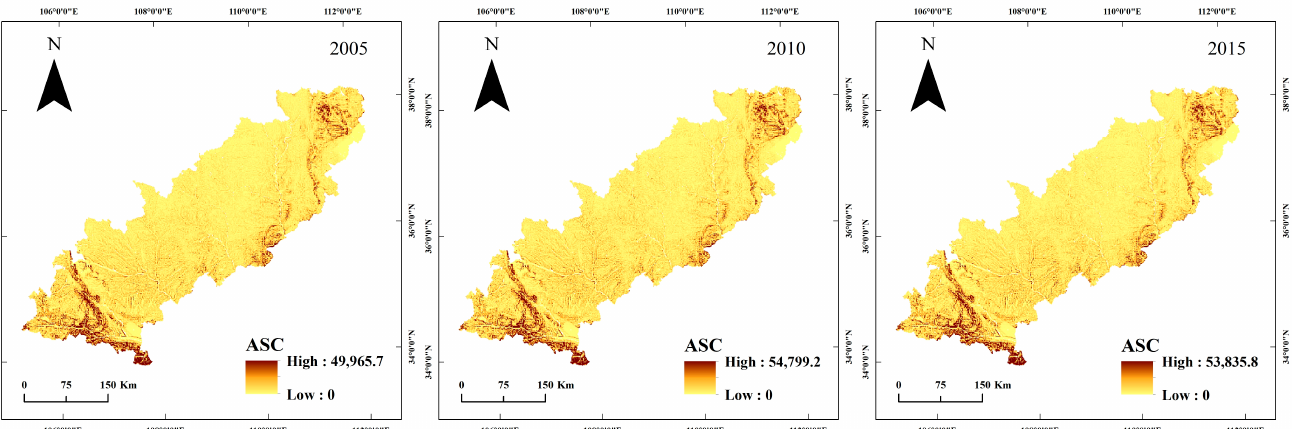
Figure 14. Distribution of soil conservation services in the Loess Plateau Ecological Screen from 2005 to 2015.